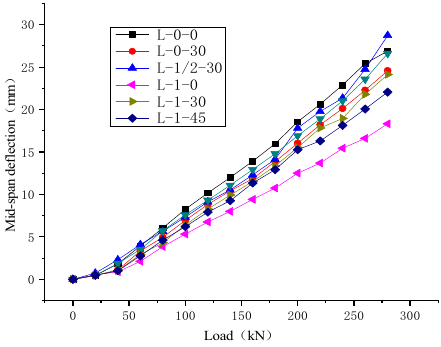
Figure 7. Comparison of the deformation of each test beam.